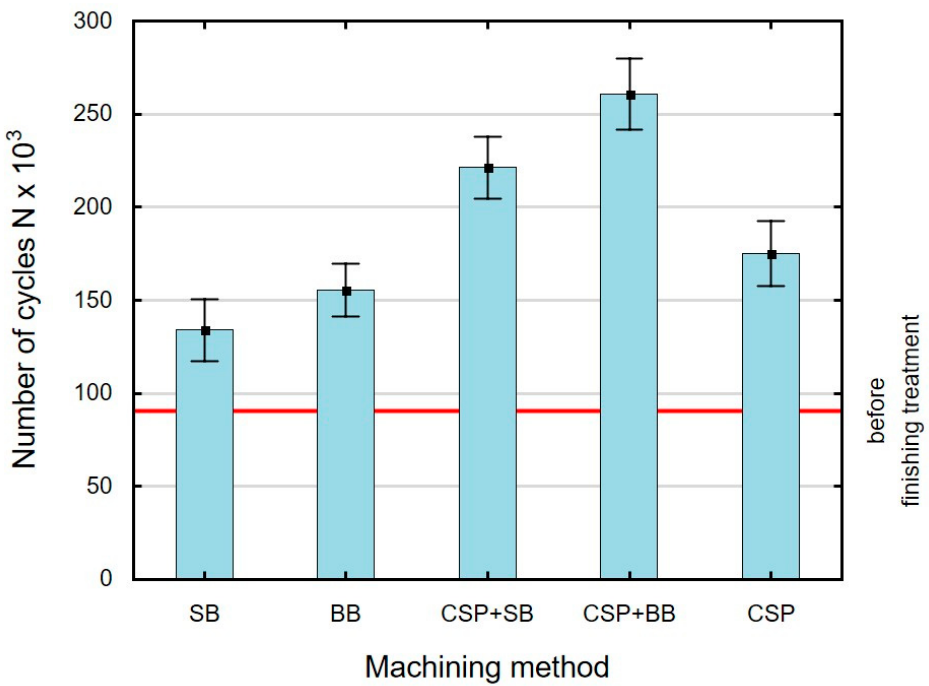
Figure 15. Effect of the finishing treatment on fatigue life (SB—slide burnishing, BB—ball burnishing, CSP + SB—centrifugal shot peening + slide burnishing, CSP + BB—centrifugal shot peening + ball burnishing, CSP—centrifugal shot peening).